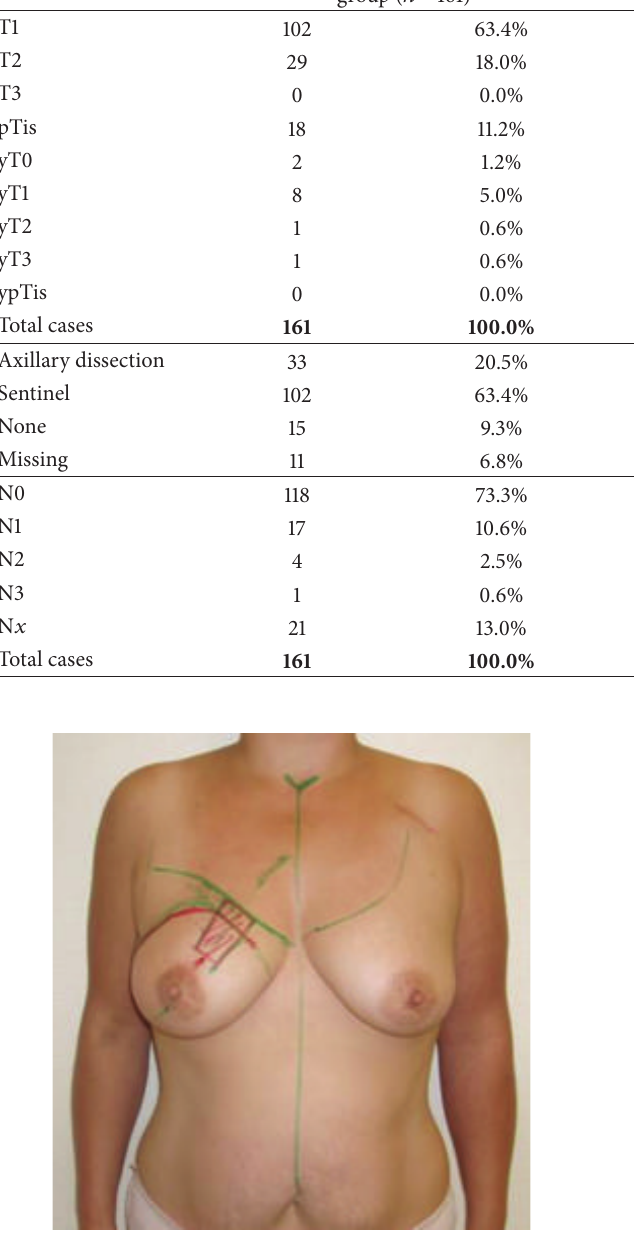
Figure 4: Same patient, oblique